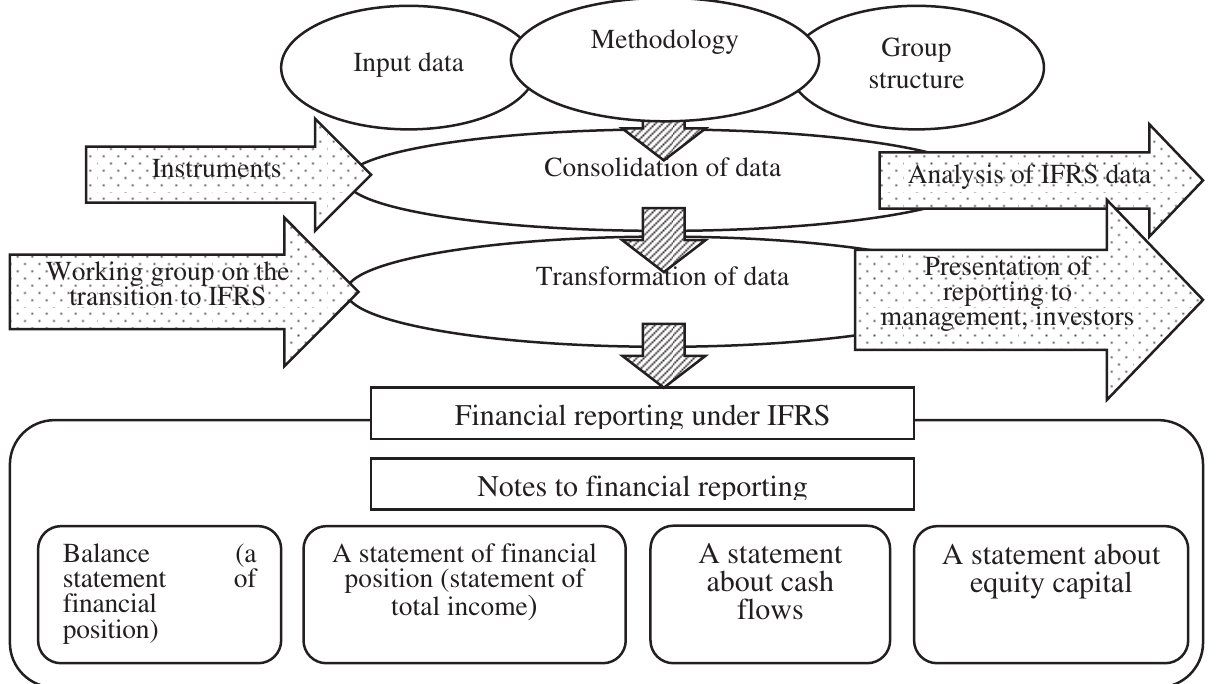
Fig. 4. A system for data collection and financial reporting under IFRS